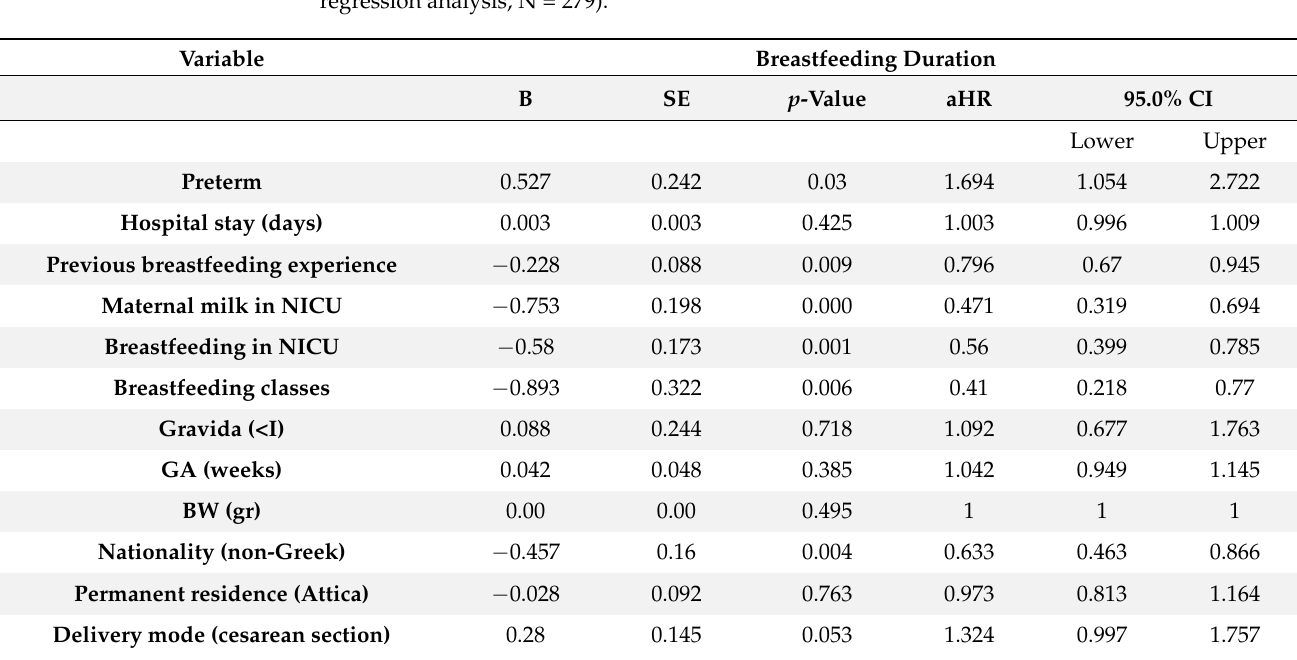
Table 5. Prognostic factors associated with duration of any breastfeeding (Cox proportional hazards regression analysis, N =